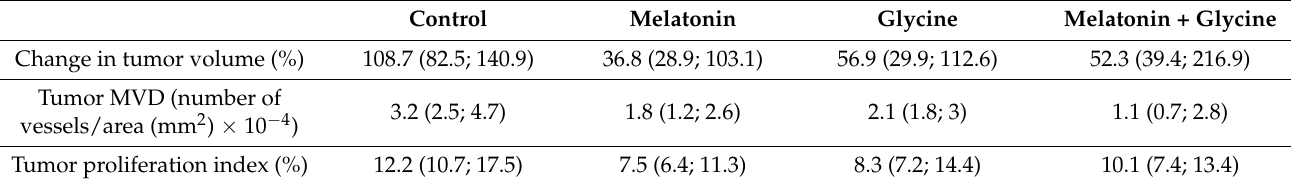
Figure 5. Tumor characteristics and subgroup analysis. ( A ) Change in tumor volume was expressed as tumor volume on day 14 (mm 3 )/tumor volume on day 8 (mm 3 ) × 100%; ( B ) Number of platelets before tumor implantation in combined treatment with melatonin and glycine group subgroups according tumor volume change during study period (increase/decrease); ( C ) Tumor microvascular density (MVD) was expressed as number of vessels and tumor area (mm 2 ) ratio × 10 − 4 based on immunohistochemistry images of CD31; ( D ) Tumor proliferation index in study groups based on immunohistochemistry images of Ki67. Data presented as median and interquartile range. Each cross mark represents individual case. Table 2. Comparison of tumor characteristics in different treatment